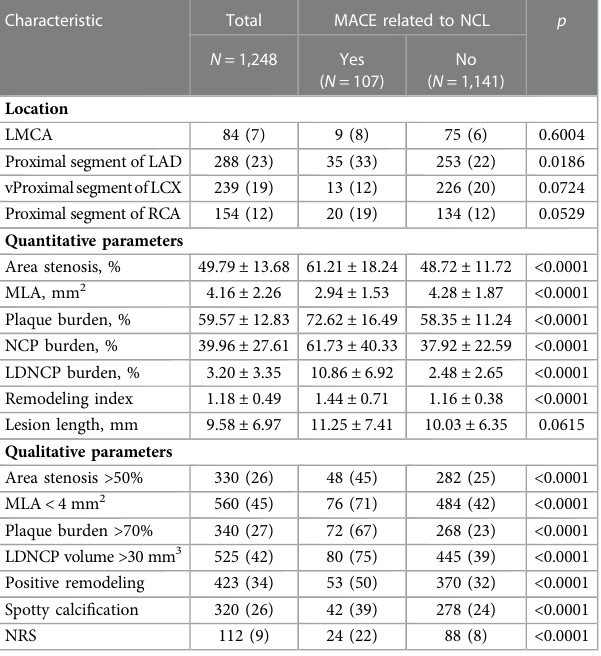
TABLE 3 CCTA-measured plaque characteristics of NCLs.